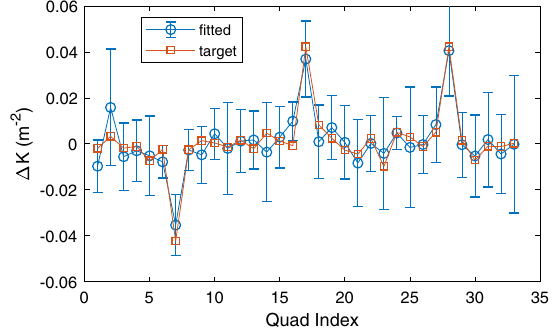
FIG. 19. Comparison of fitted quadrupole gradients and the target values for the LCLS undulator section, with trajectory scan amplitude up to 300 μ m and BPM noise signal of 1 μ m.